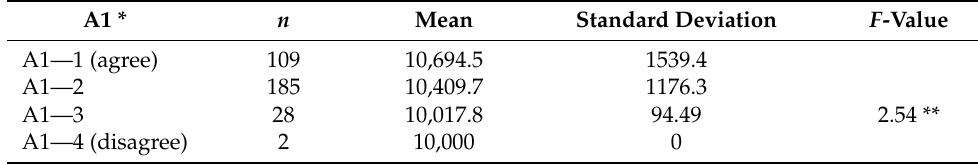
Table 6. Results of One-way ANOVA (WTP of Q’ type 1).